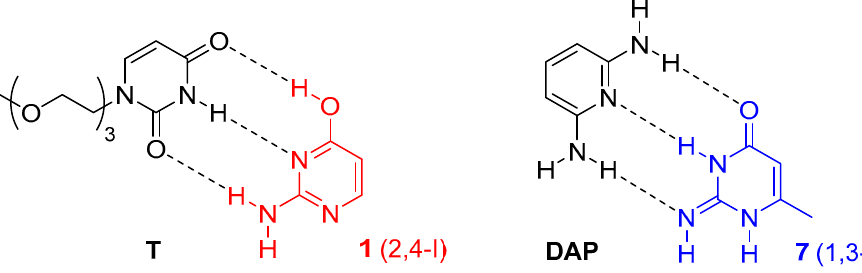
Figure 5. The expected structure of the enol tautomer 2,4-I of isocytosine 1 in a complex with thymine derivative T ( left ), and the structure of the imino tautomer 1,3-I of compound 7 in a complex with diaminopyridine ( DAP , right ). These complexes were not observed.